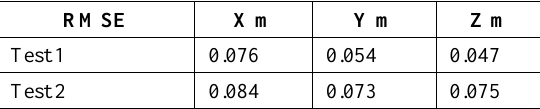
Table 4: Evaluating the system Check point coordinates